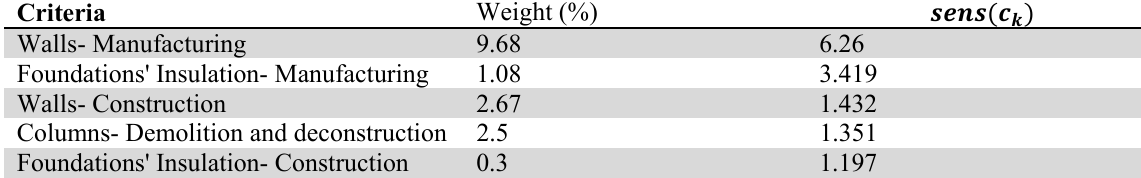
Most sensitive project stages in acidification potential occurrence